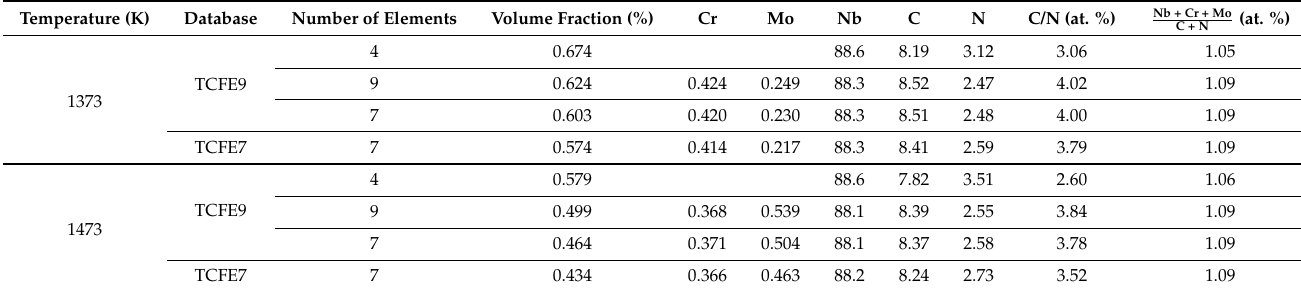
Table 2. Equilibrium contents (wt.%) of the main elements in Nb(C,N) as well as Nb(C,N) volume fraction and atomic ratios at 1373 and 1473 K obtained using the TCFE7 and TCFE9 databases for different numbers of elements considered in the composition of 316Nb steel.